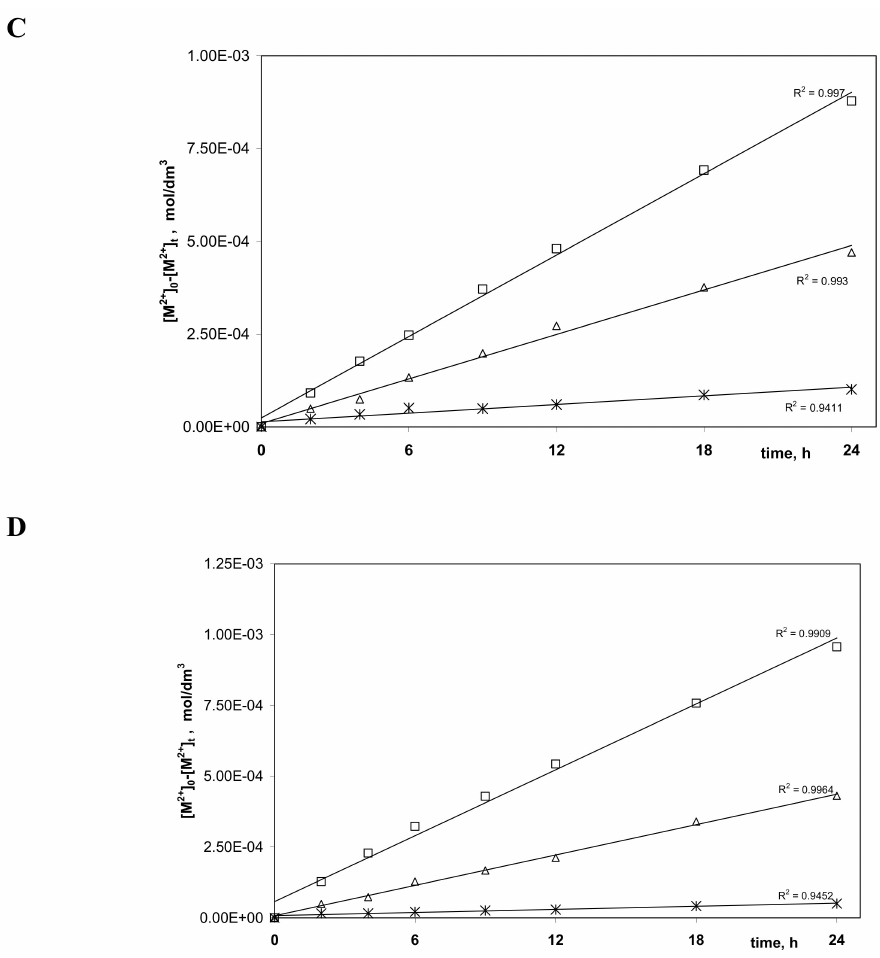
Figure 5. Relation of [M 2 + ] 0- [M 2 + ] t plotted vs. time for Zn(II) ( (cid:3) ), Cd(II) ( ∆ ), and Ni(II) (*), transport across PIMs doped with 1-octylimdazole ( A ), 1-octyl-2-methylimidazole ( B ), 1-octyl-4-methylimidazole ( C ) and 1-octyl-2,4-methylimidazole ( D ),